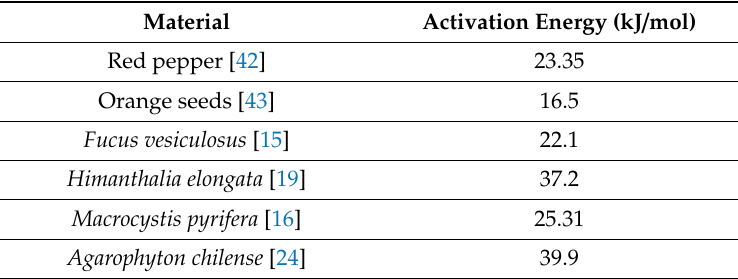
Table 6. Comparison of D 0 and E a for other